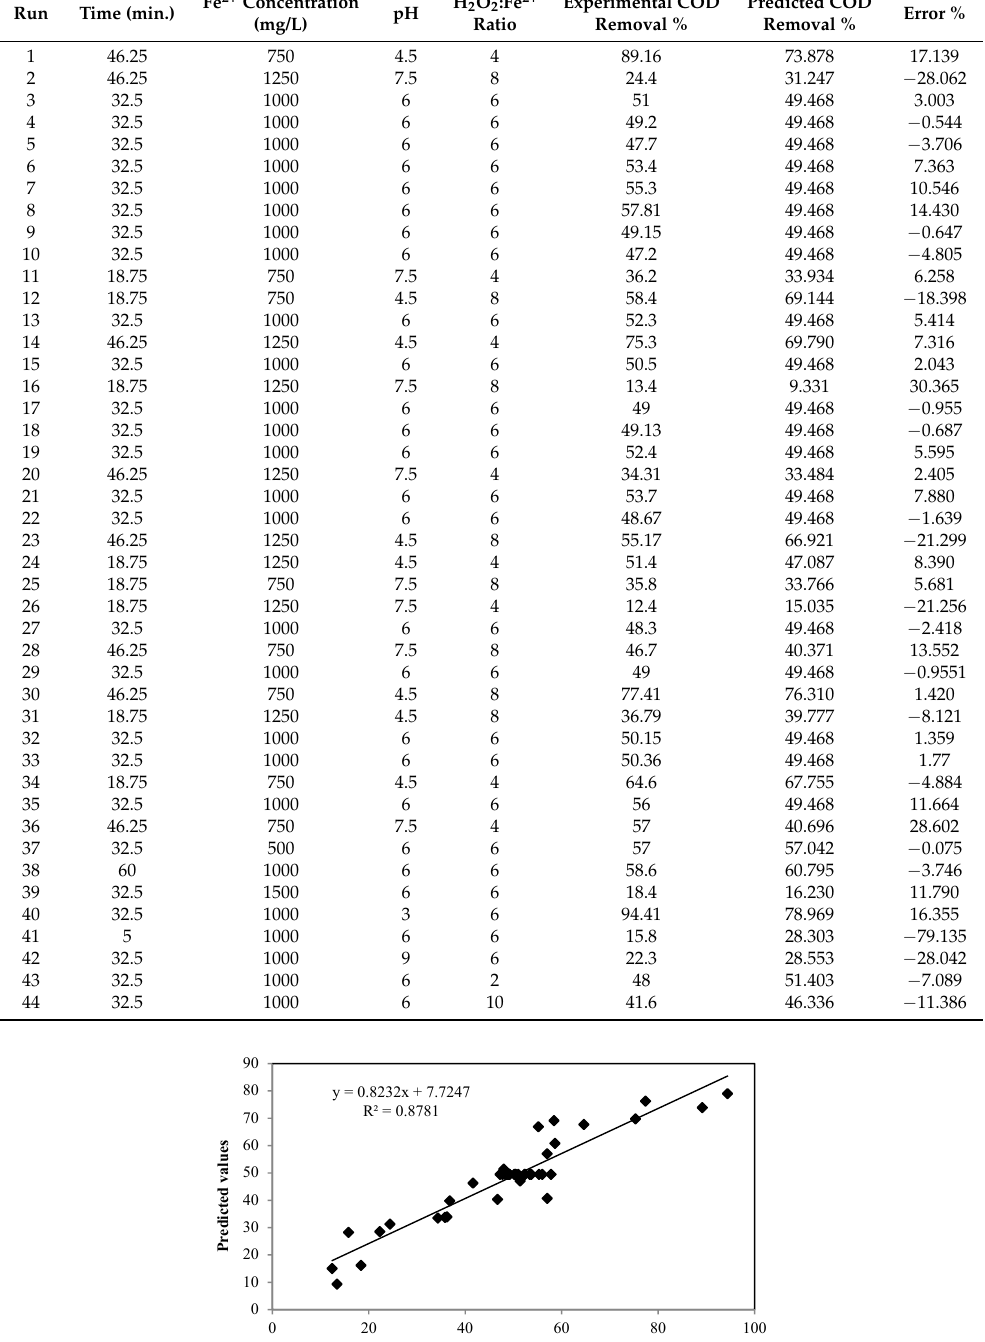
Table 4. ANN design magnitudes and experimental results for COD removal.